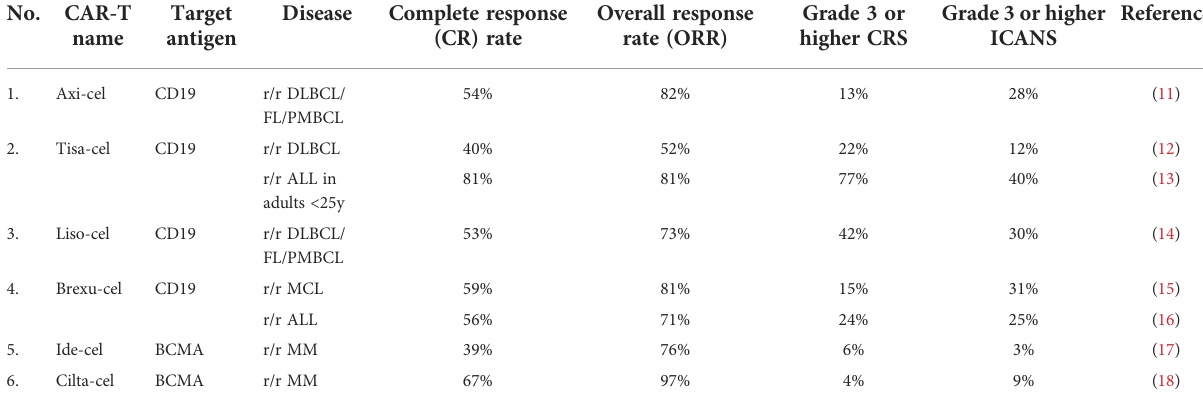
TABLE 1 FDA-approved CAR-T therapies – second-generation CAR-T